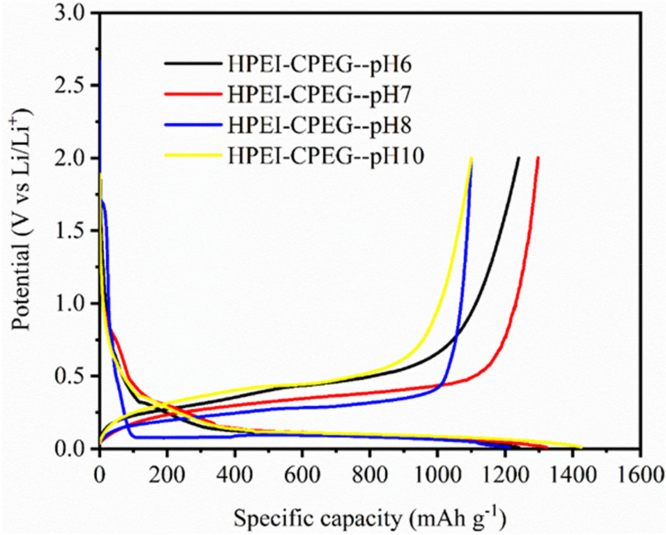
Figure 5. Comparison of charge/discharge for HPEI-CPEG-pH6, HPEI-CPEG-pH7, HPEI-CPEG-pH8, and HPEI-CPEG-pH10 binders.